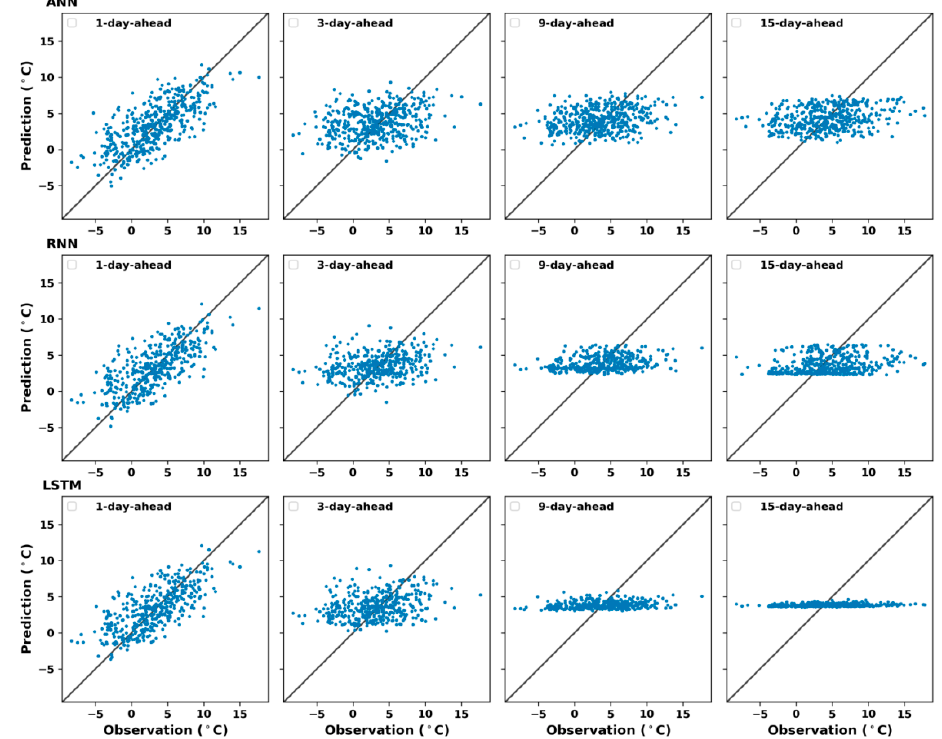
Figure 11. Prediction of k days ahead using ANN ( top ), RNN ( middle ), and LSTM ( bottom ) models for winter, k = 1,3,9,15.